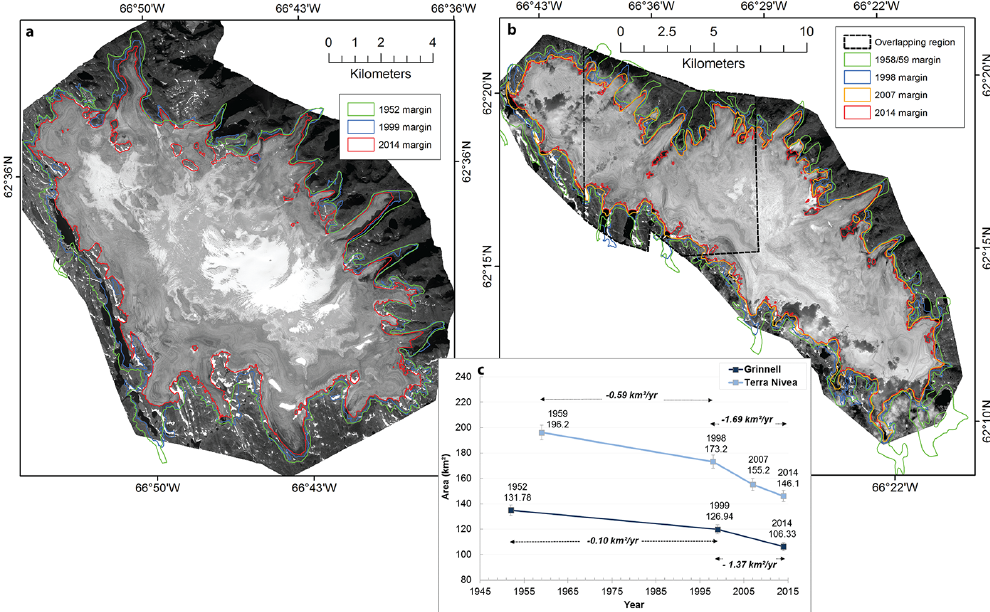
Figure 2. (a) Pléiades orthoimage of Grinnell Ice Cap (3 August 2014) superimposed with areal extents from 1952, 1999 and 2014. (b) Pléi- ades orthoimages of Terra Nivea Ice Cap (14 August 2014 on the east side and 26 August 2014 on the west side) superimposed with areal extents from 1958/59, 1998, 2007 and 2014. The overlapping area between the two orthoimages is represented by the black dashed polygon. (c) Historical and recent area changes for both ice caps. Error margins were estimated at 5% for historical areas and at 3% for 1998 and later outlines (Sect.